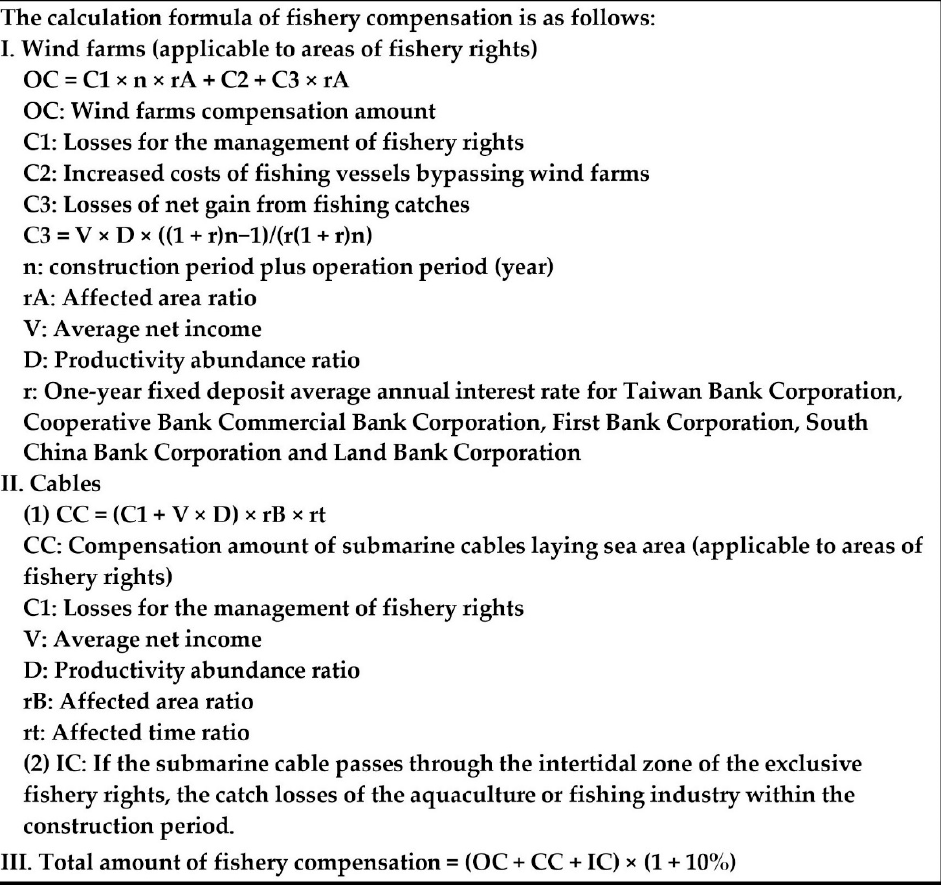
Figure 1. The calculation formula of fishery compensation amounts. Source: Authors’ own based on [50].